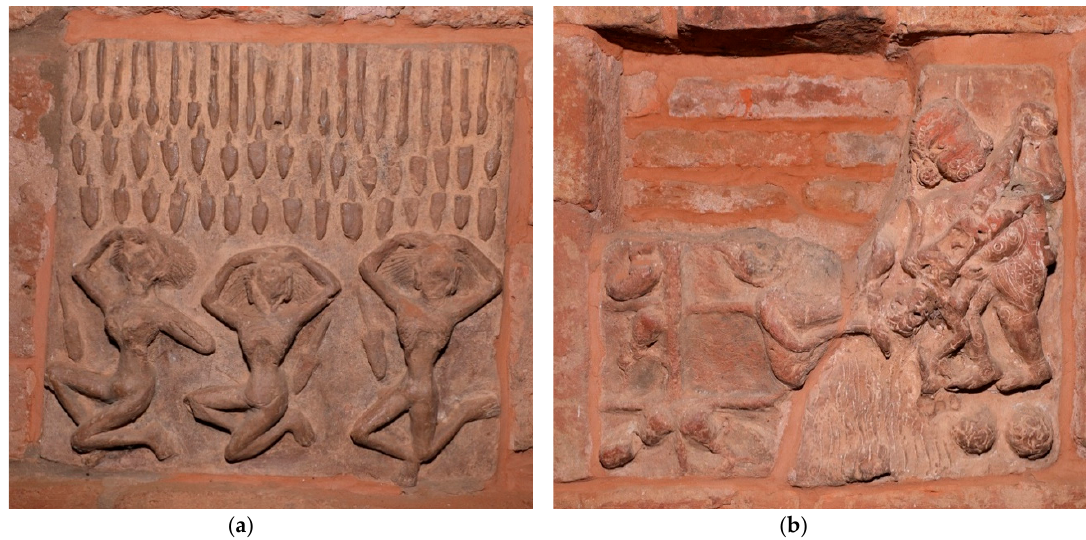
Figure 33. Pagan, Hpetleik Stupa, 11th century. Two uninscribed hell images one showing denizens being showered with sharp weapons, in the other a ferocious demon holding victims upside down is shoving them into a fire. Surrounding the latter images were other candidates, tied up, awaiting their turn. ( a ) Punishment by swords raining from the sky. ( b ) Punishment by being shoved into the fire. Missing are images of the bodies awaiting their turn.